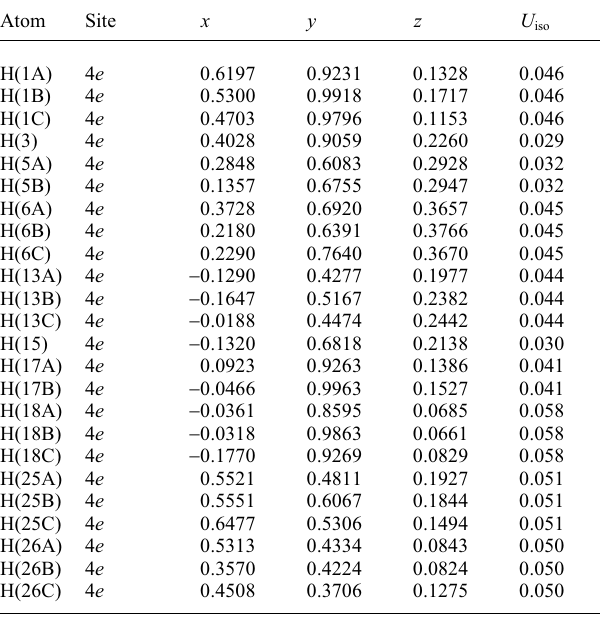
Table 2. Atomic coordinates and displacement parameters (in Å 2 )